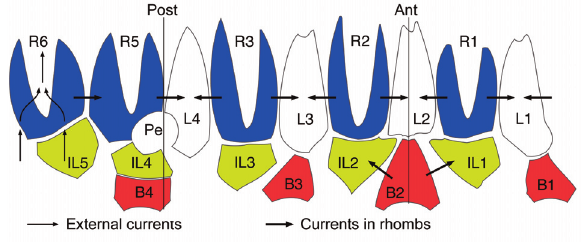
Fig. 12. Plate arrangement of Cystoblastus with external currents, currents within pectinirhombs and plane of anterior–posterior symmetry indicated. Ant, anterior; B1–B4, basals; IL1–IL5; infralaterals; L1–L4, laterals; Pe, periproct; Post, posterior; R1– R3, R5, R6, radial plates. External currents only shown in R6. One arrow for each